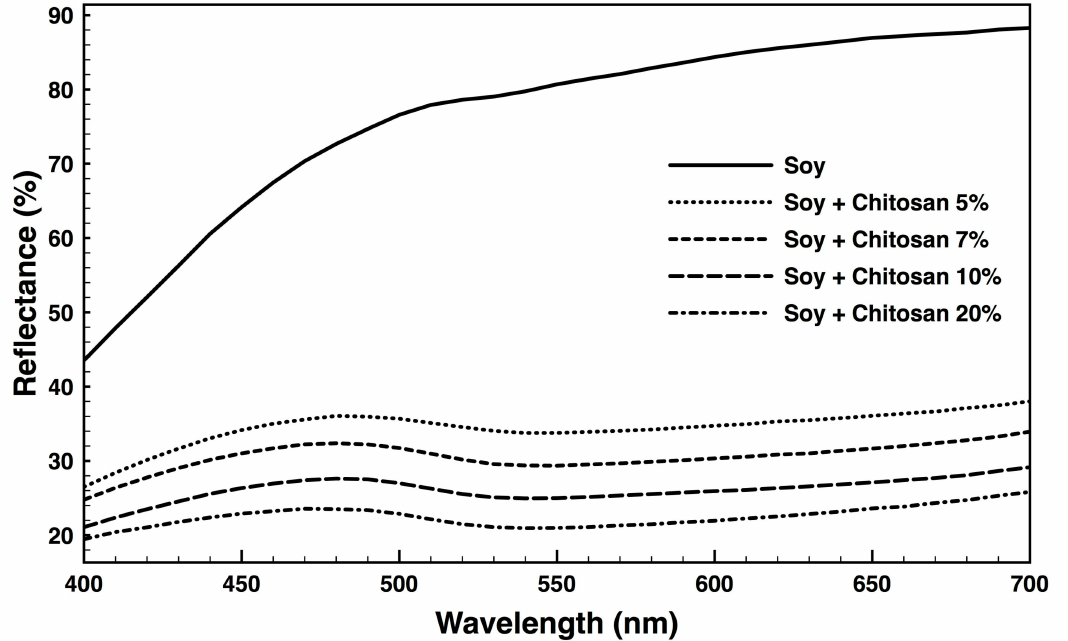
Figure 1. Fabric’s reflectance after 5, 7, 10 and 20% chitosan dilutions surface treatment, obtained in the range of 400 to 700 nm at standard illuminant